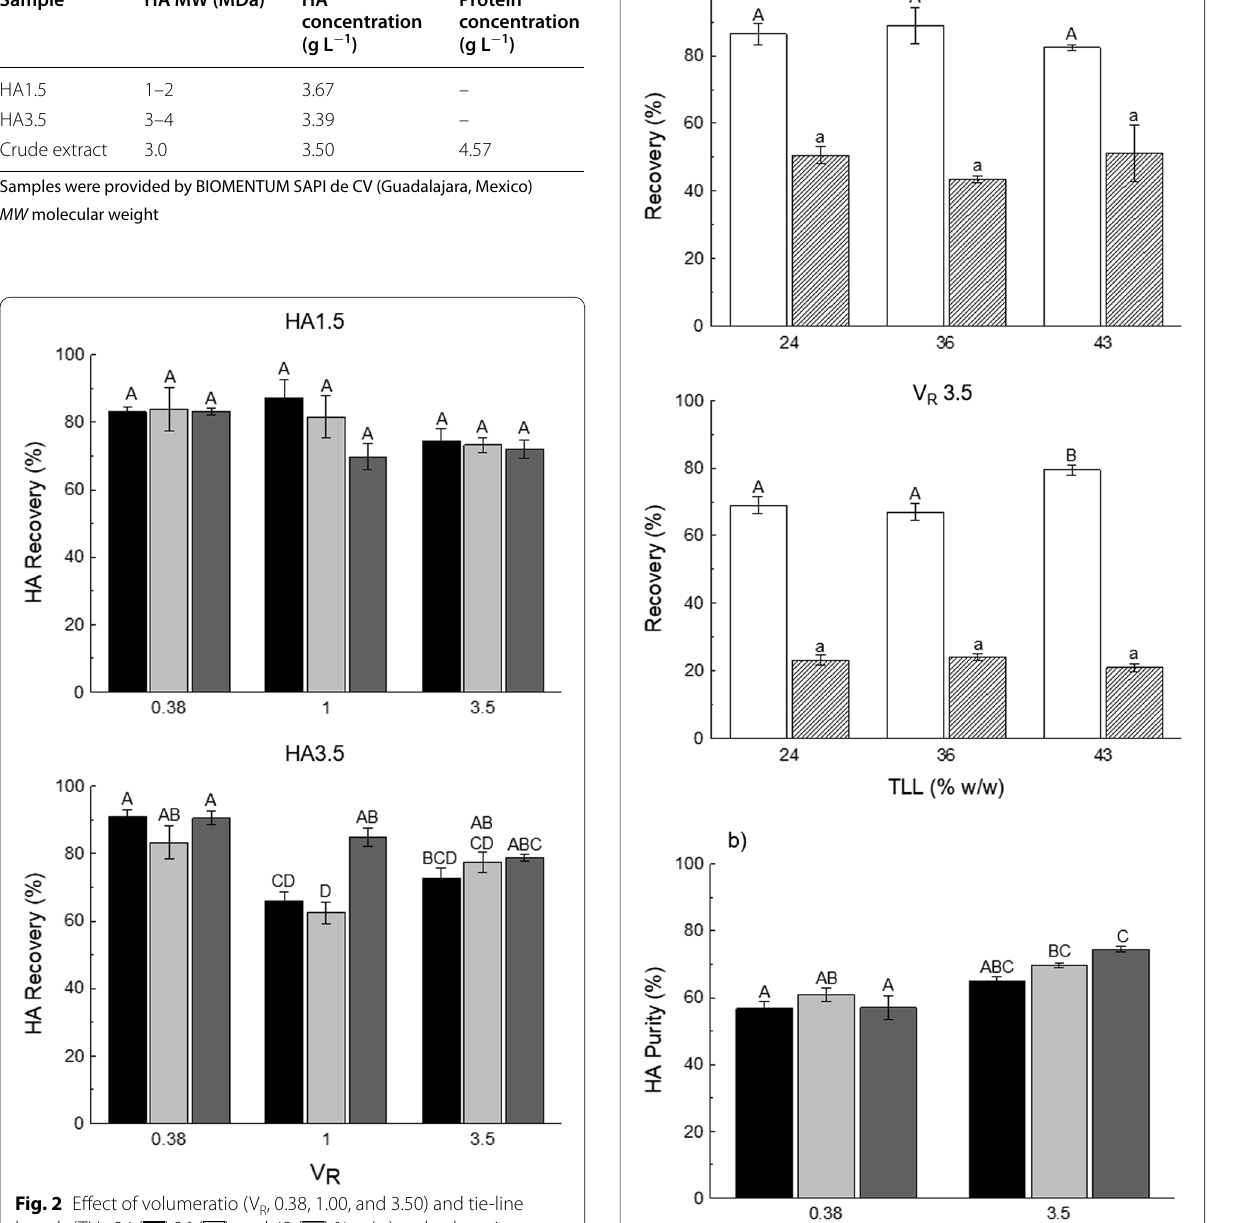
Table 2 Composition of pure and crude extract of Streptococcus equi subsp. zooepidemicus ‑derived hyaluronic acid (HA) samples